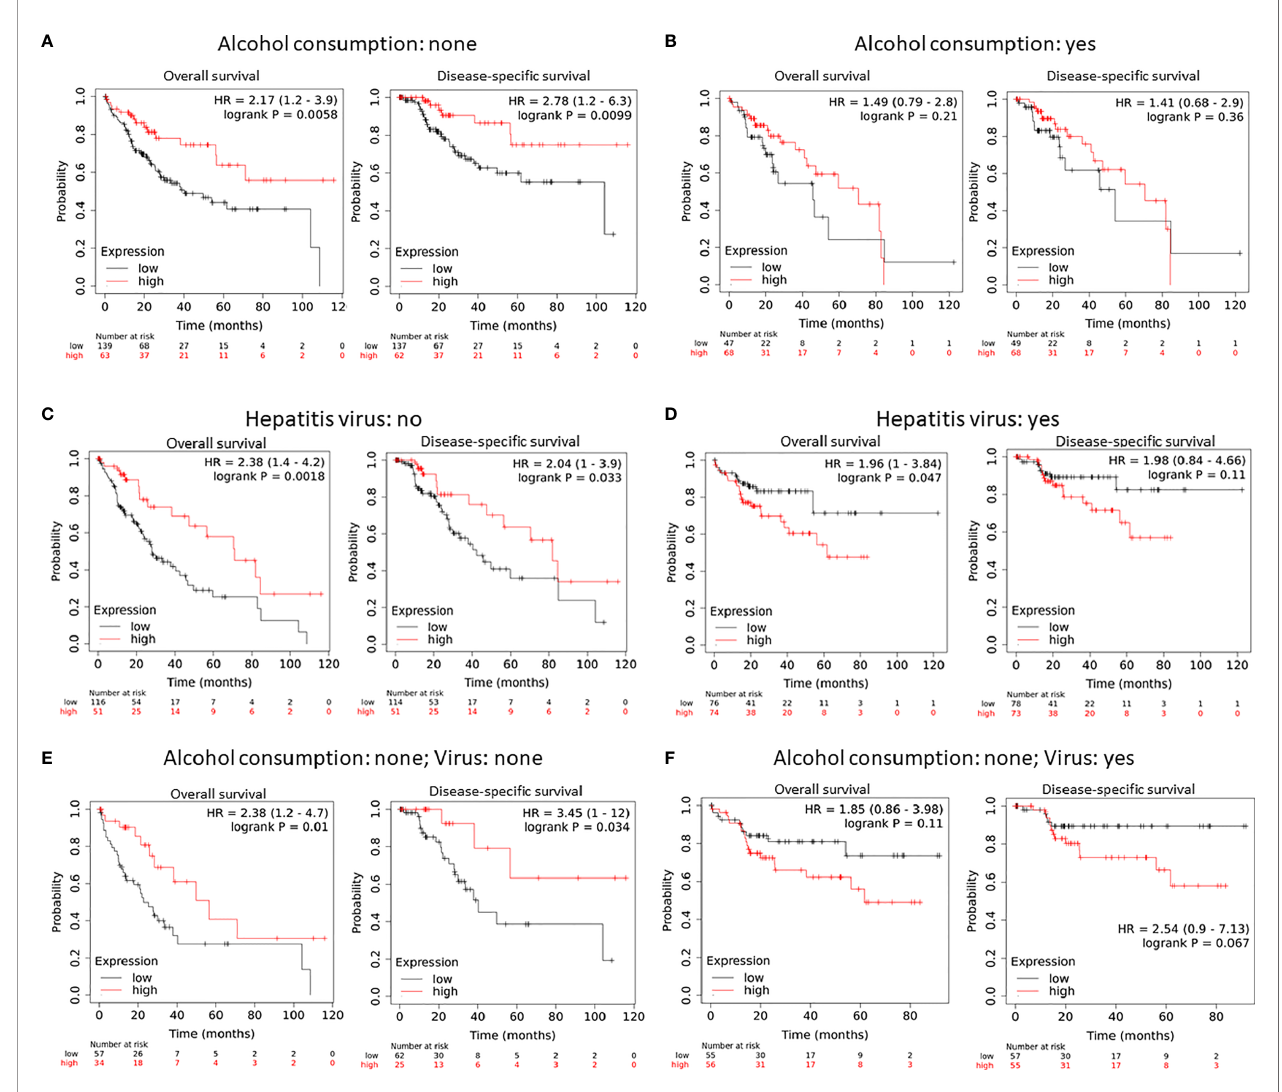
FIGURE 4 | Hepcidin downregulation is a worse survival factor in non-alcoholic liver cancer patients without viral hepatitis. (A, B) The survival status was analyzed on the Kaplan-Meier Plotter platform in patients with or without alcohol consumption. In panel A, the hepcidin expression range (RNA sequencing data) was 0- 116709 and the cutoff value was 542. In panel B, the hepcidin expression range was 0-120133 and the cutoff value was 68 using the minimum p-value approach, as described (26). Case numbers in each group were listed at the bottom of the fi gure. (C, D) The survival status was analyzed in patients with or without viral hepatitis. The cutoff value for hepcidin expression was set as 440 (range 0-58791) in panel C and 168 in panel D (range 0-120133). (E, F) The survival status was analyzed in none-alcoholic patients with or without viral hepatitis. The cutoff value for hepcidin expression was 140 (range 0-49344) for the overall survival but 542 for the disease-free survival in (E) . The cutoff value in D was 168 (range